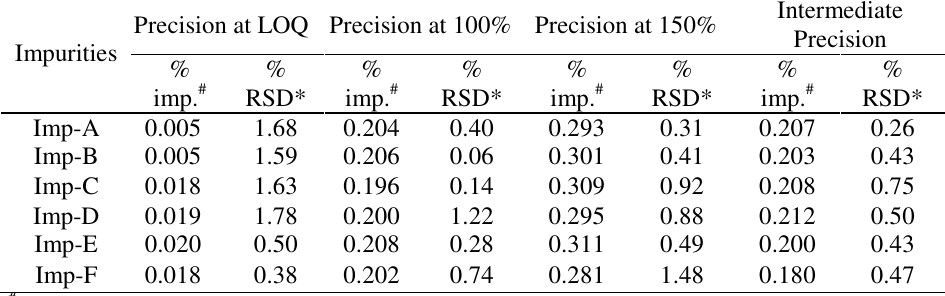
Table 5. Precision at three levels (LOQ, 100% and 150%) and intermediate precision results §